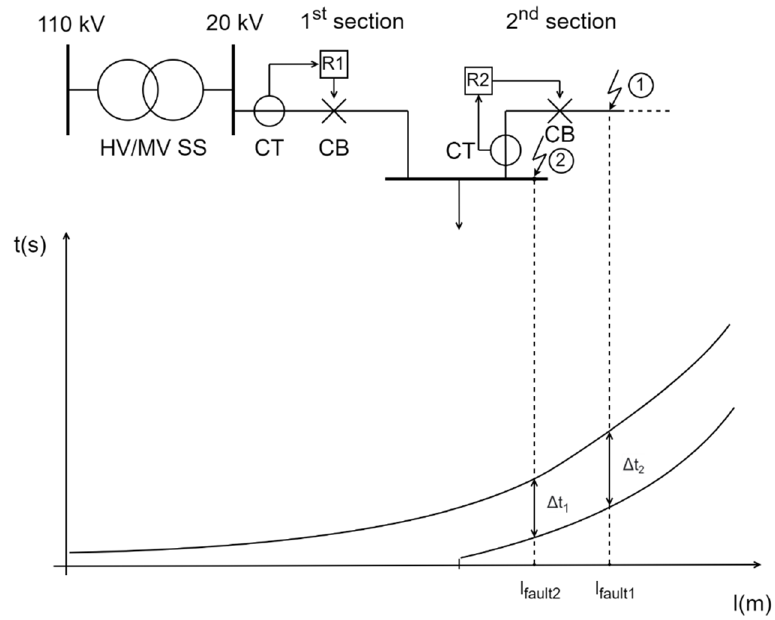
Figure 8. On the calculation of 3-phase short circuit at the beginning of the line.